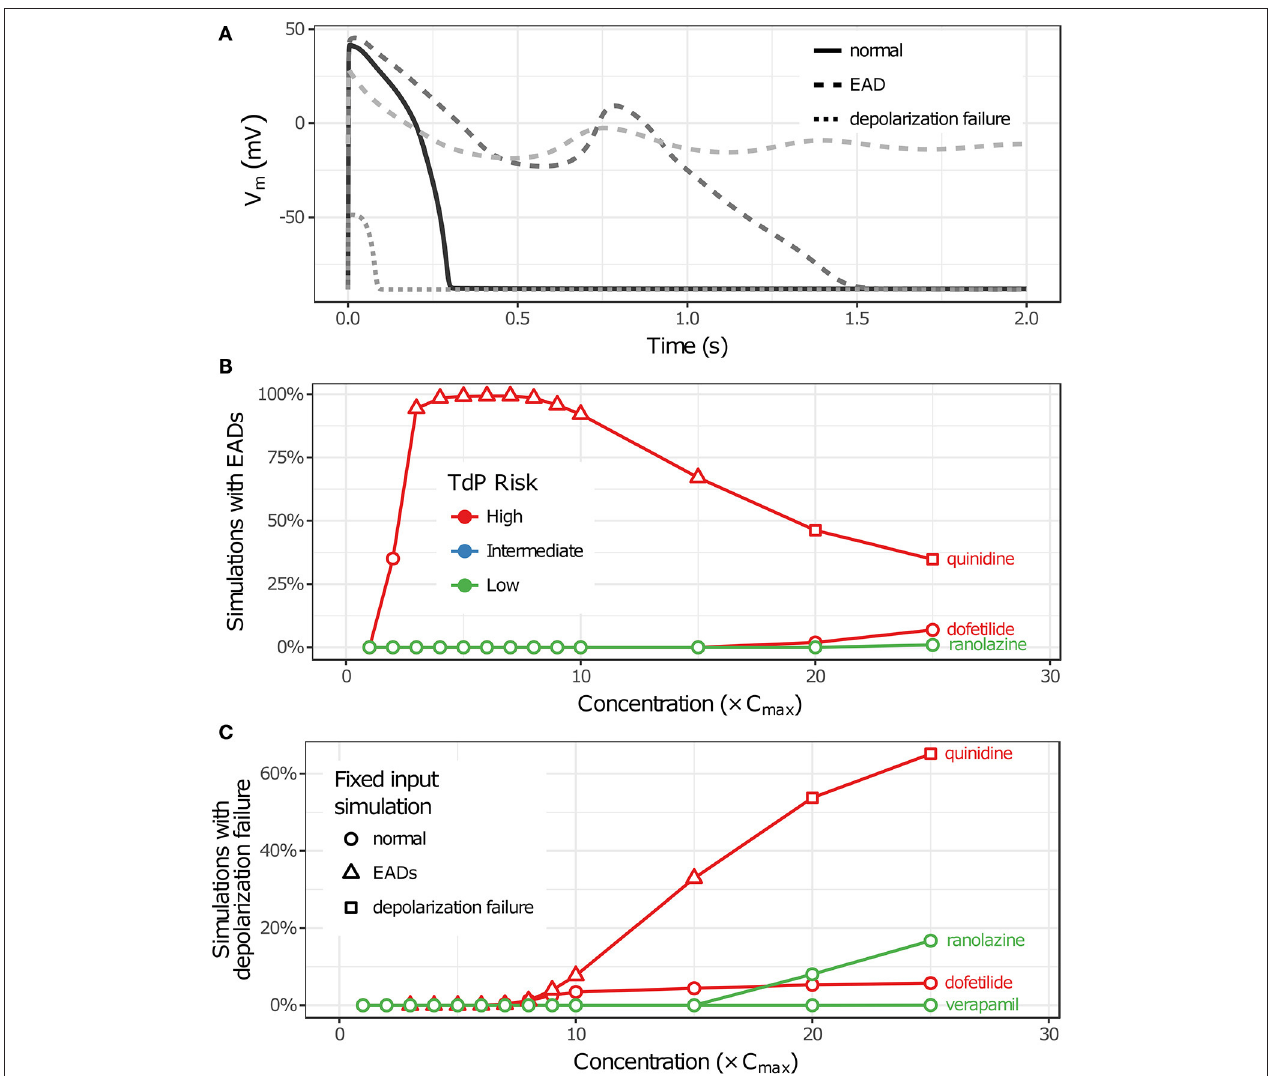
FIGURE 5 | Repolarization and depolarization abnormalities in AP simulations. (A) Traces showing representative examples of beats with normal APs (solid), EADs (dashed), or depolarization failure (dotted). (B,C) The percentage of uncertainty-input simulations (2,000 total) in which EADs occurred (B) or which had complete depolarization failure (C) is shown as a function of drug concentration in (B,C) , respectively. Only results for drugs that had these events at the simulated concentrations (1 − 25 × C max ) are plotted. (Note that ranolazine had 19 simulations with EADs at 25 × C max ; verapamil only had one instance of depolarization failure occurring at 25 × C max .) Markers indicate whether simulations with fixed inputs produced normal Aps (circles), EADs (triangles), or depolarization failure